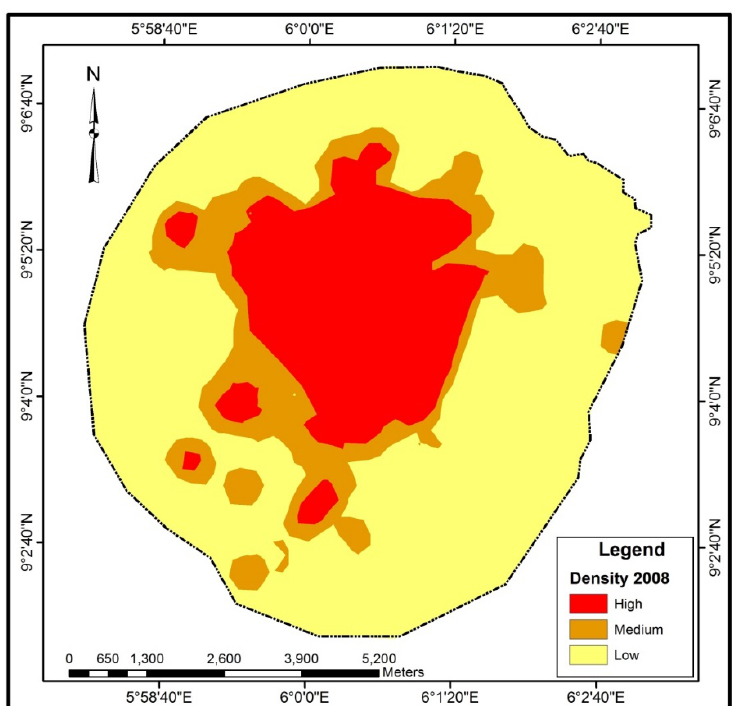
Fig. 6. Residential density classification for the year 2008 (Developed by the authors, 2020).